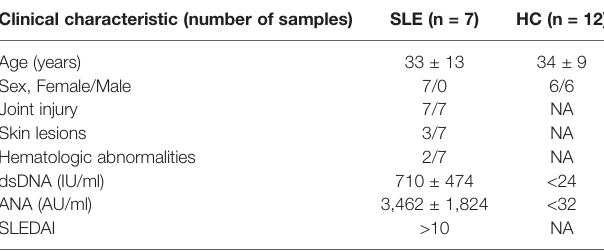
TABLE 1 | Clinical features of patients with SLE and NC studied for scATAC-seq experiments. Clinical characteristic (number of